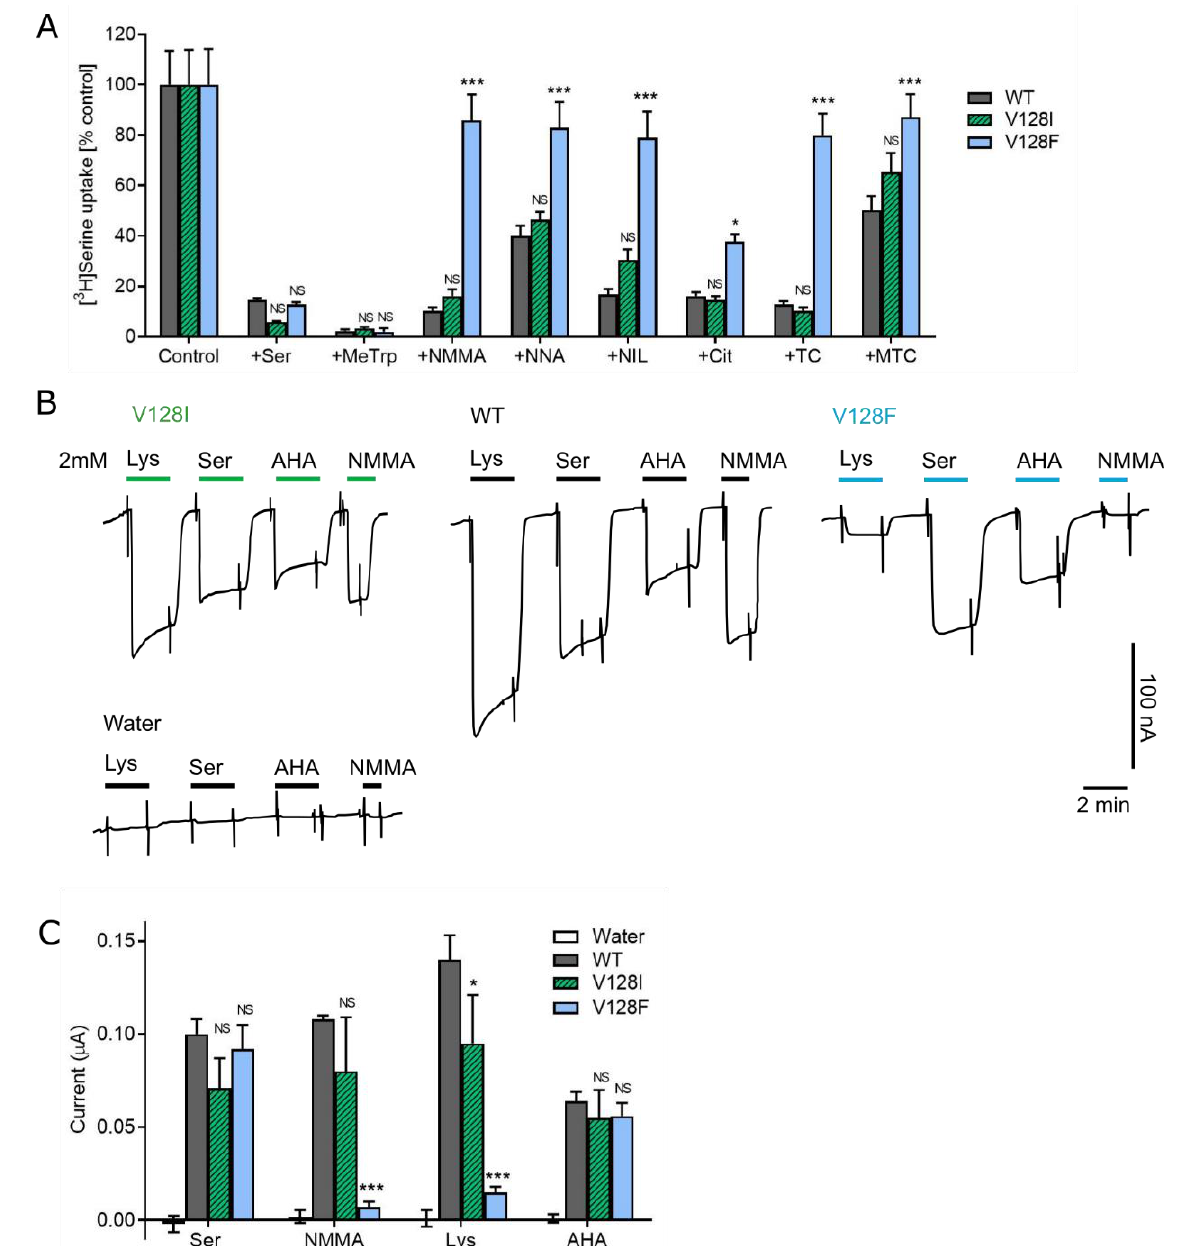
Figure 4. NOS inhibitors are not transported by the SLC6A14-V128F mutant. ( A ) Serine (10 µM) uptake in the absence (control) and presence of various amino acid analogues and the SLC6A14 inhibitor MeTrp in SLC6A14 wild-type (WT) and V128I and V128F mutants. Compounds are: MeTrp, α -methyl- DL -tryptophan; NMMA, N G -monomethyl- L -arginine; NNA, N G -nitro- L -arginine; NIL, N 6 -(1-iminoethyl)- L -lysine; Cit, L -citrulline; TC, L -thiocitrulline; MTC, S-methyl- L -thiocitrulline. All compounds were used at 2.5 mM except NIL which was used at 5 mM (due to its reported lower affinity for SLC6A14 [15]. SLC6A14-specific transport is shown (i.e., after the subtraction of uptake into water-injected oocytes, measured under identical conditions). n = 18 – 20. ***, p < 0.001; *, p < 0.05; NS, p > 0.05 vs. WT. ( B ) Example traces showing transporter-associated inward current induced by various amino acids and analogues (all 2 mM) in SLC6A14-WT, V128I and V128F mutants, and water-injected oocytes as a control. AHA, 2-aminoheptanoic acid. ( C ) Mean inward currents induced by 2 mM of each compound [as shown in ( B )] after 120 s of superfusion. n= 3 – 5. ***, p < 0.001; *, p < 0.05; NS, p > 0.05 vs. WT.